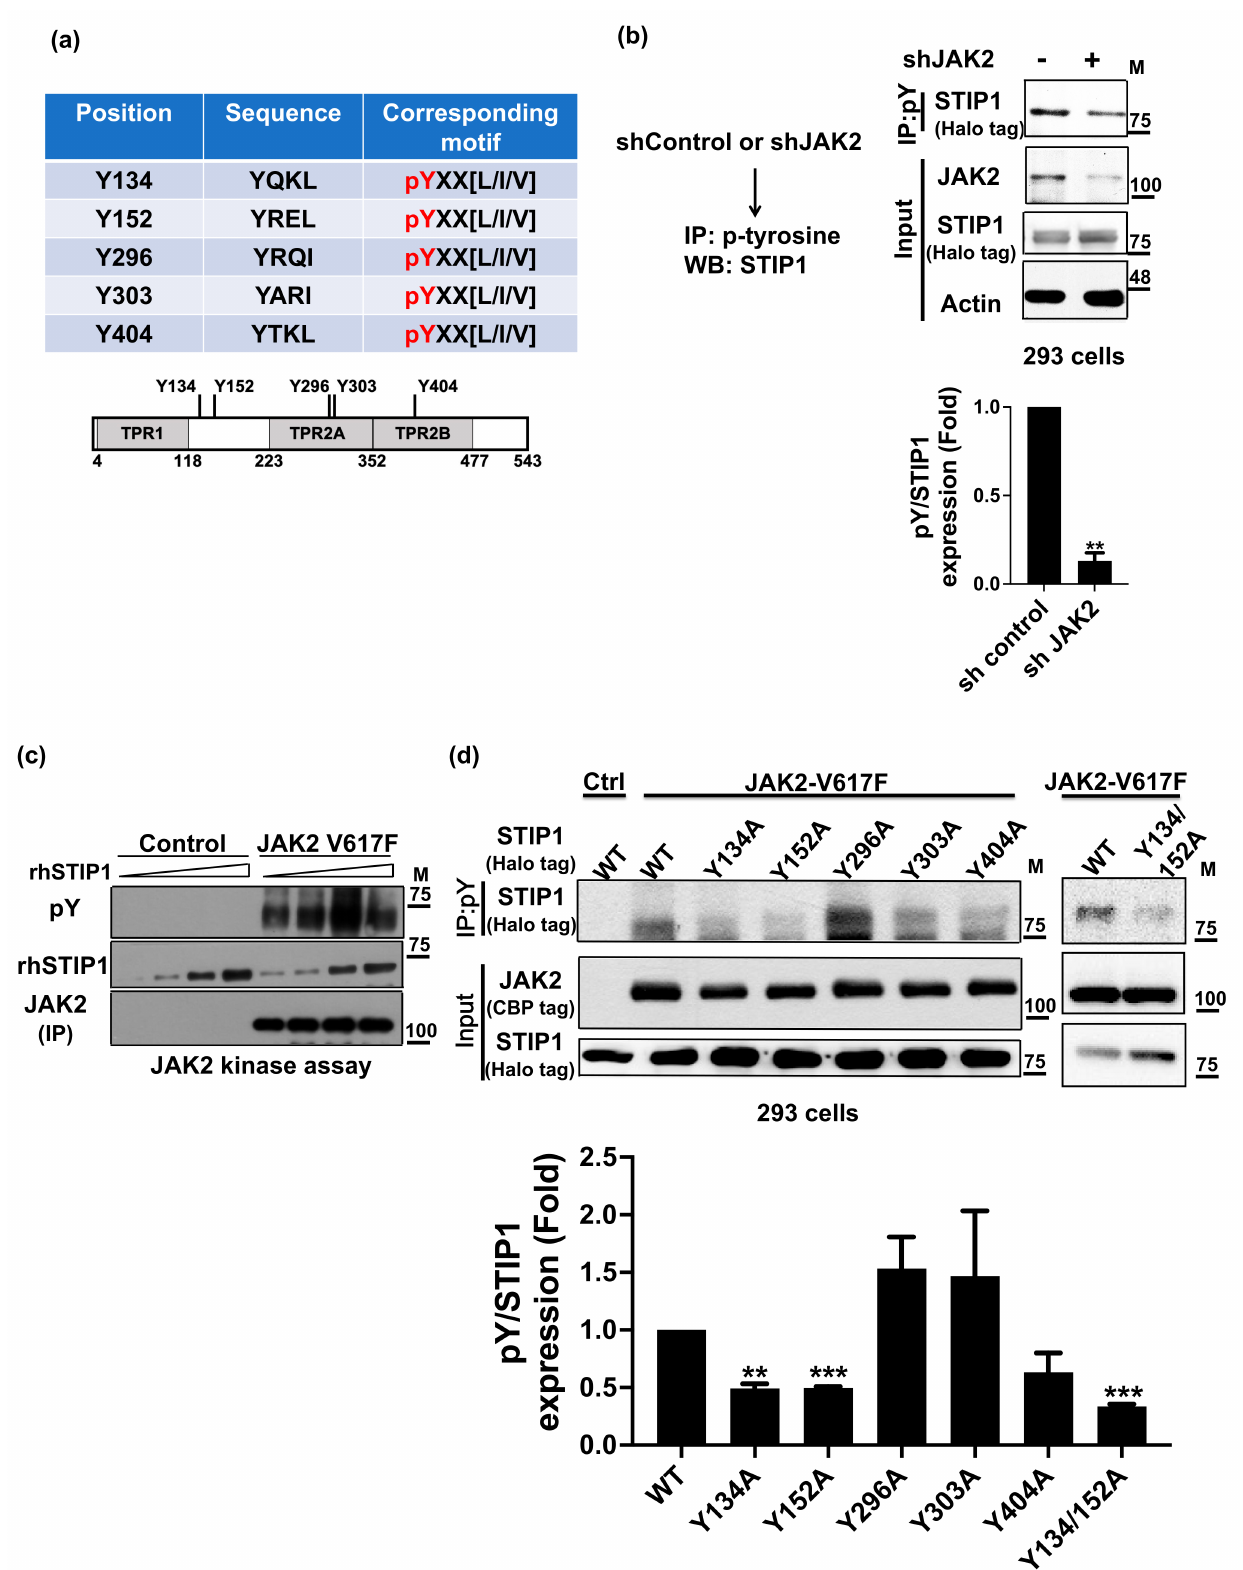
Figure 1. STIP1 undergoes JAK2-mediated phosphorylation. ( a ) Using the human protein reference database website (http://hprd.org/PhosphoMotif_finder; accessed on 7 May 2018), five